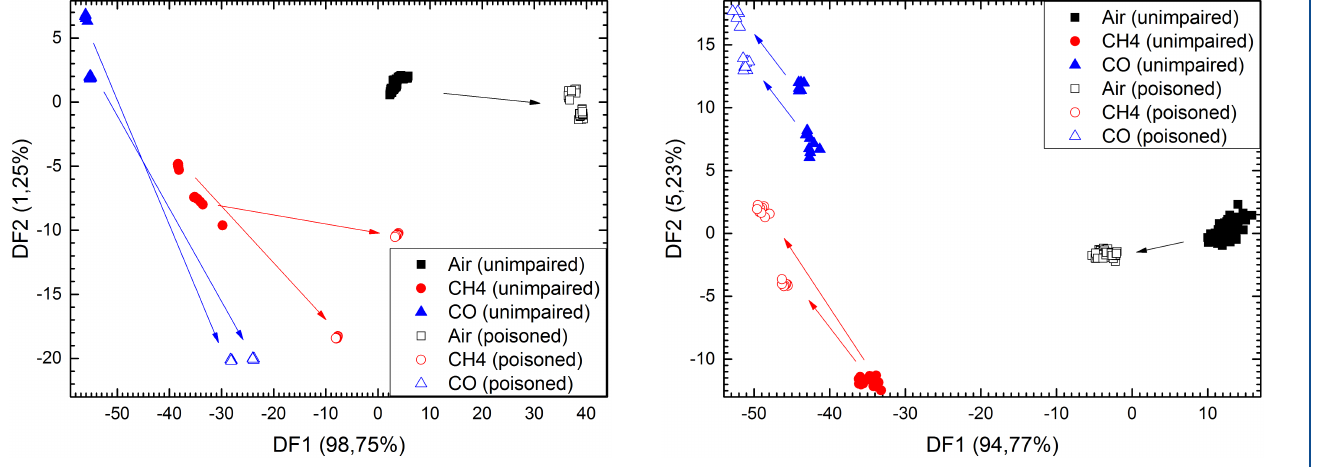
Figure 11. LDA of five TCO features (absolute impedance mean value differences) for unimpaired (solid symbols) and poisoned (open symbols) sensor, acquired with the FoBIS impedance spec- troscope.